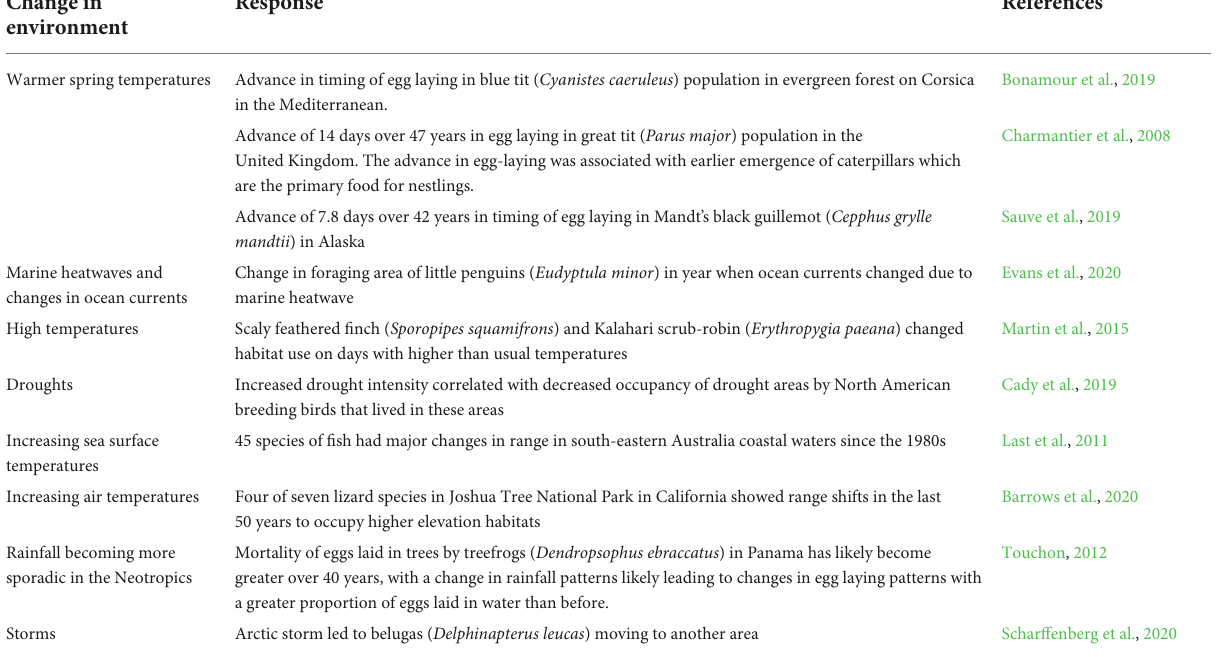
TABLE 1 Examples of responses of animals to changes in the environment associated with climate and weather variables. Change in